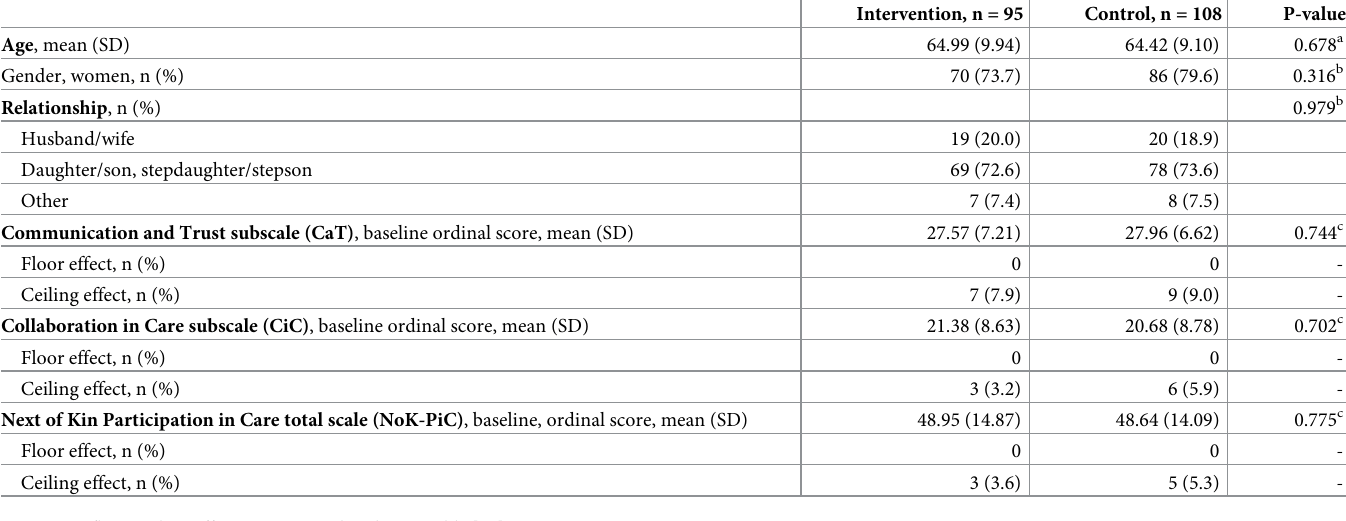
Table 1. Sample characteristics at baseline for the intervention and control